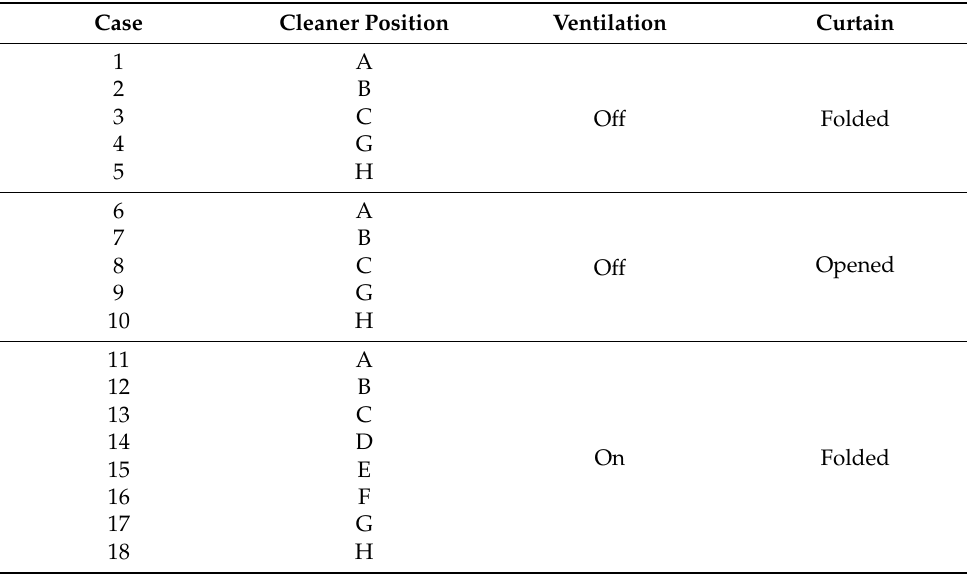
Table 1. Operation cases based on the air cleaner